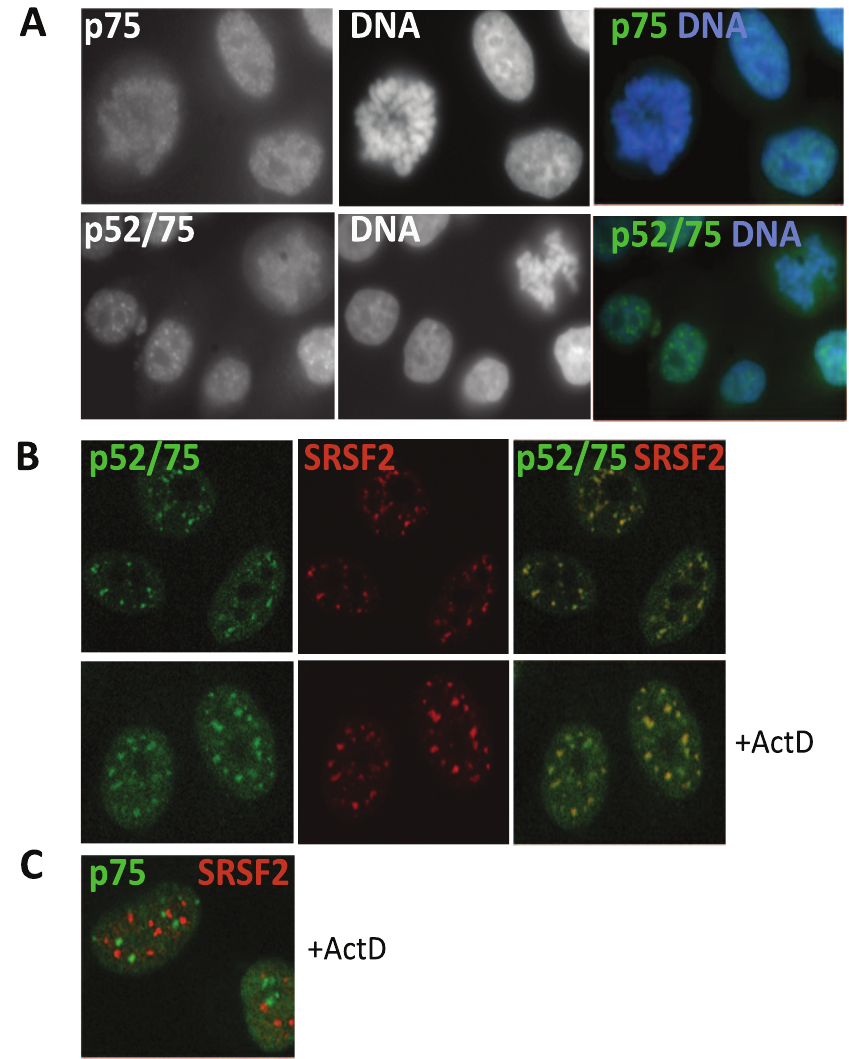
Figure 4. Sub-cellular localization of Psip1/p52 and p75. A) Immunofluorescence and wide-field epifluorescence microscopy on human cells with; (upper row) p75-specific antibody A300-848, (lower row) A300-847 which can recognize both p52 and p75. DNA was counterstained with DAPI. B) Co-immunofluorescence of Psip1/p52 (green/A300-847) and SRSF2 (red) analyzed by confocal microscopy in untreated (upper row), or actinomycin D (ActD) treated cells. C) Co-immunofluorescence of Psip1/p75 (green/A300-848) and SRSF2 (red) in ActD treated cells and analyzed by